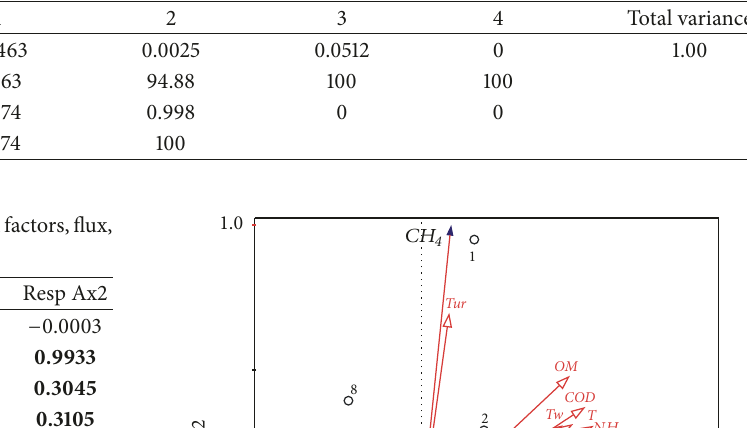
Table 7: Eigenvalues for RDA axis and the correlation of species-environment factors.